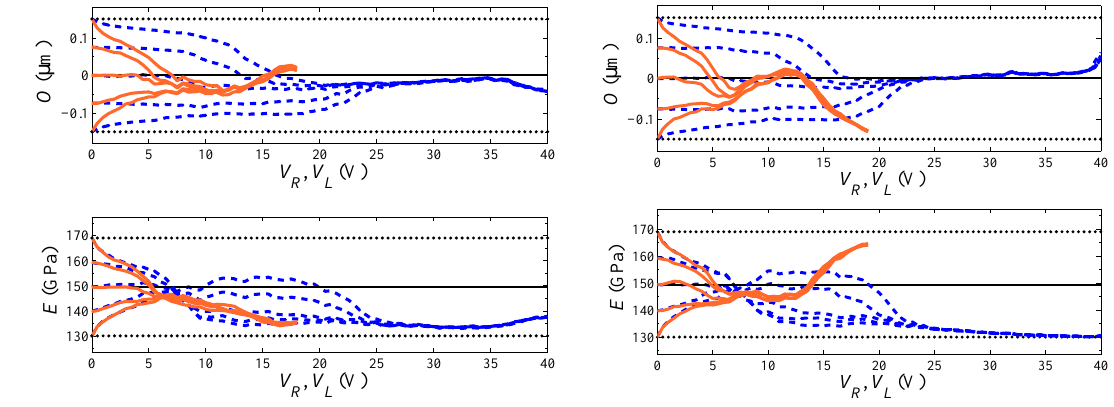
Figure 7. Evolution of the estimates of ( top ) O and ( bottom ) E , at varying filter initialization. Blue dashed lines: rotational actuation through V R ; orange solid lines: lateral actuation through V L . ( a ) Specimen #2, leading to consistent final estimates, and ( b ) Specimen #5, leading instead to non-consistent